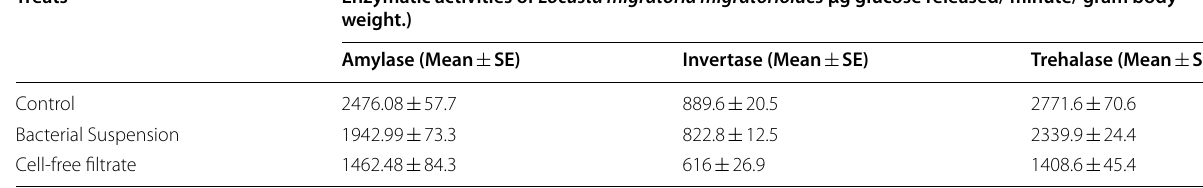
Table 4 Effect on amylase, invertase, and trehalase enzymatic activities of Locusta migratoria migratorioides